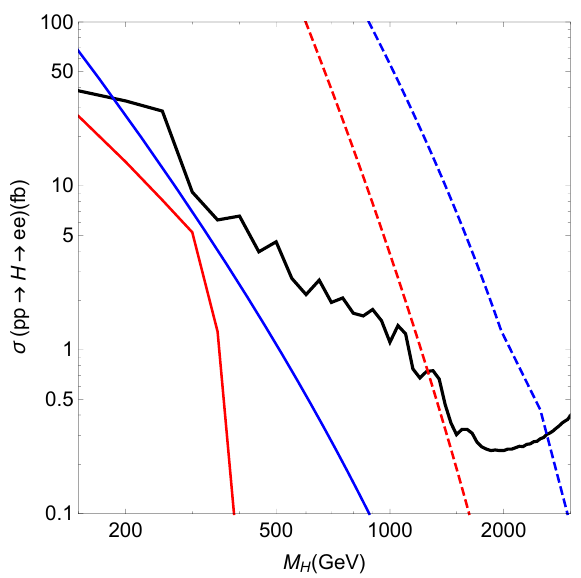
Figure 2 . (cid:27) ( pp ! H; A ! e + e (cid:0) ) as a function of m H = m A for (cid:20) e = 500. The region above the black curve is excluded by the 8 TeV ATLAS search [26]. The theoretical predictions corresponding to the scenario de(cid:12)ned by eqs. (5.10) and (5.11) are given in blue curves, with t (cid:12) = 1000 (solid) or 4 (cid:2) 10 4 (dashed). The theoretical predictions corresponding to y A;H with tan (cid:12) = 1000 (solid) or 4 (cid:2) 10 5